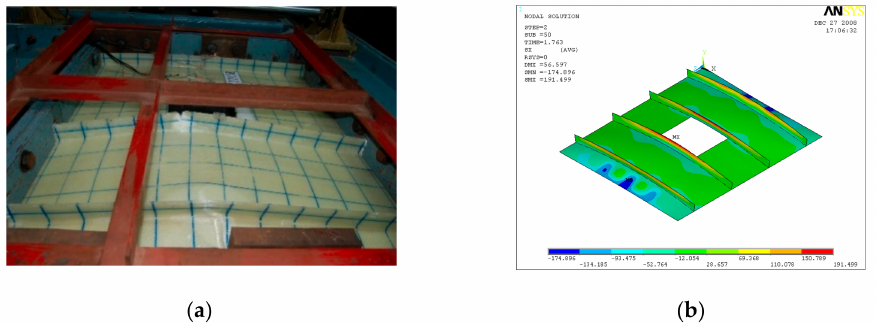
Figure 20. Failure of LSTPO3 ( a ) Experiment ( b )